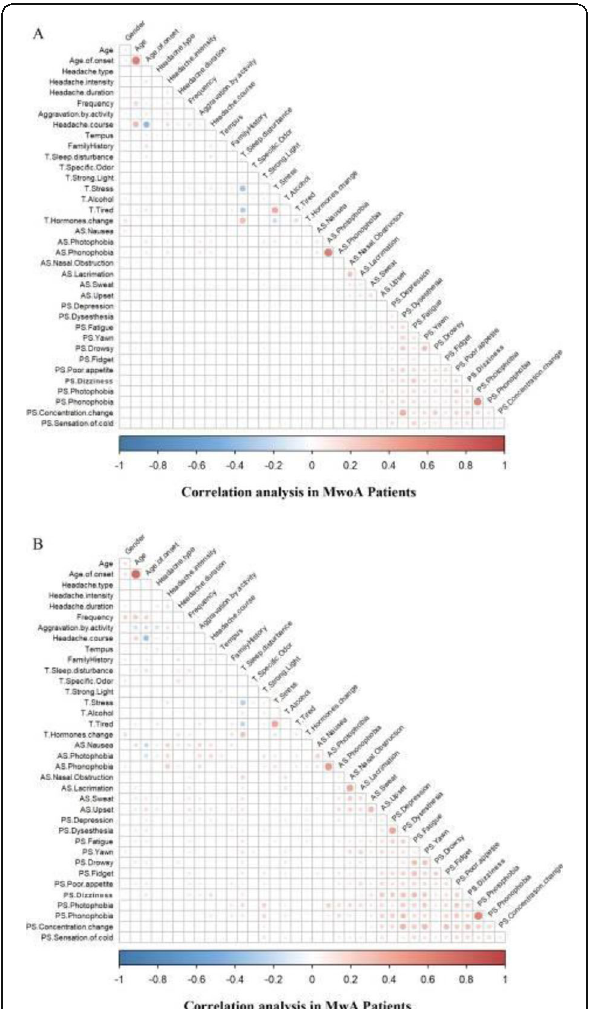
Fig. 1 (abstract P166). See text for